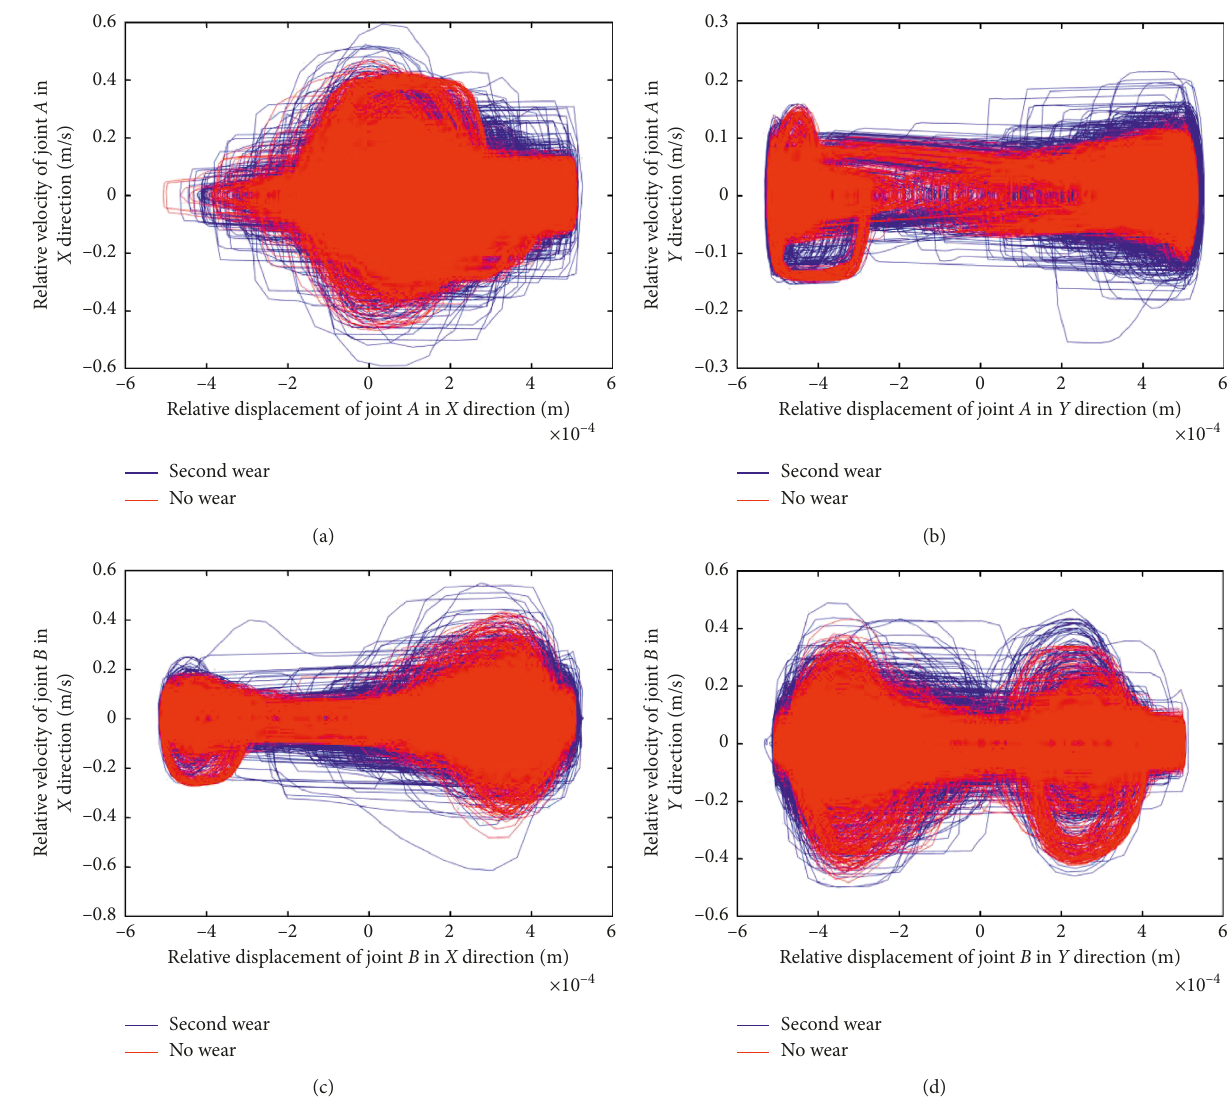
Figure 27: Phasediagramof(a)joint A inthe X direction,(b)joint A inthe Y direction,(c)joint B inthe X direction,and(d)joint B inthe Y